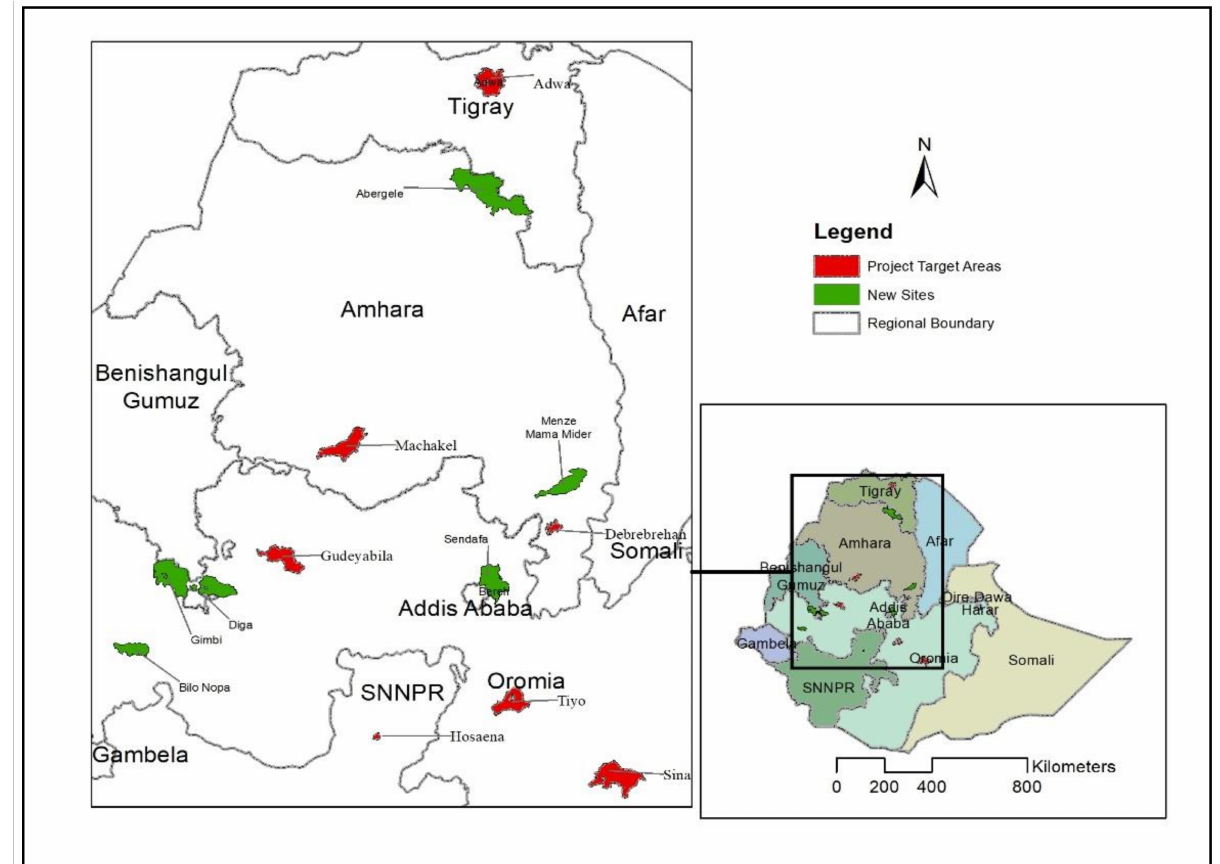
Figure 1. Map of Ethiopia showing parts of the country where two-wheel tractor-based small mechanization technologies are being promoted since 2015. Experimental sites were located Gudeya- Billa (maize), Machakel (wheat), Debre Birhan (wheat), Gimbichu (wheat) and Adwa (wheat) areas of